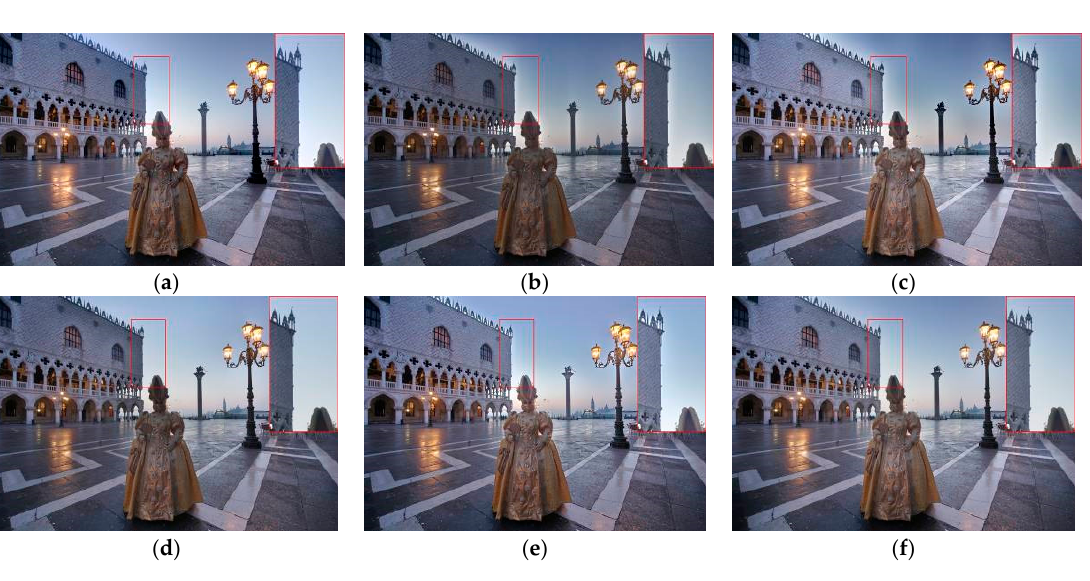
Figure 10. Performance comparison of different methods on the “Mask” image sequence. ( a ) Mertens10 [15]; ( b ) Vonikakis11 [16]; ( c ) Li13 [18]; ( d ) Liu15 [12]; ( e ) Ma18 [14]; and ( f ) the proposed method.